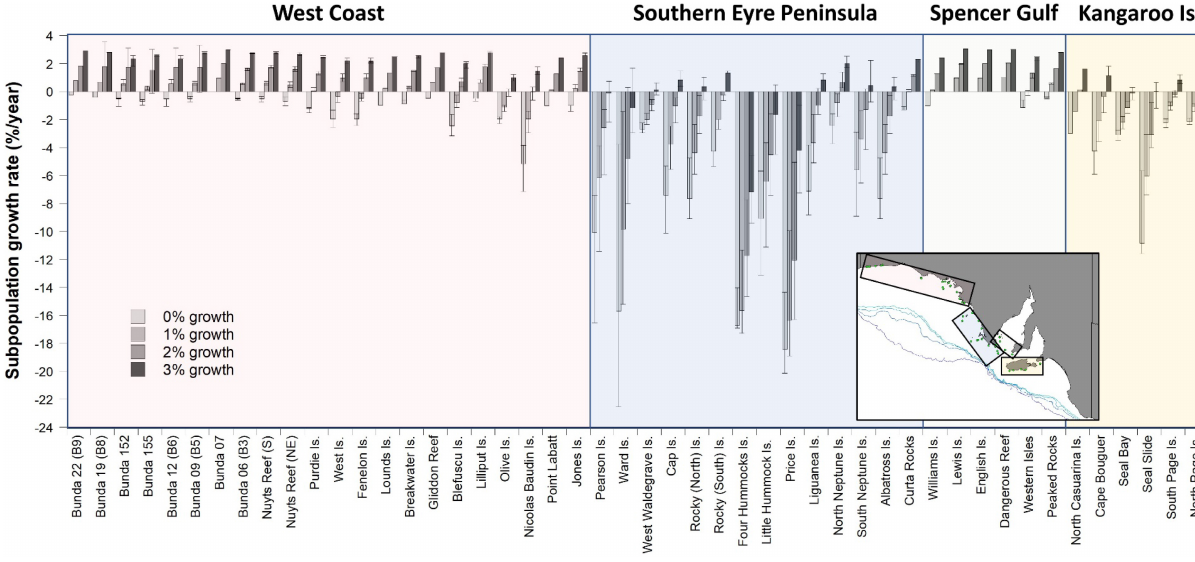
FIGURE 4 | Estimated ASL subpopulation growth rates ( ± 95% CL) based on the estimated bycatch mortalities resulting from the distribution of fishing effort in the gillnet GHAT fishery off SA from 2006 to 2009 (inclusive). Subpopulation growth rates are estimated for 34 breeding cycles ( ∼ 50 years) for four different intrinsic annual growth-rate scenarios (0, 1, 2, and 3%). Four regions are identified: West Coast, Southern Eyre Peninsula, Spencer Gulf and Kangaroo